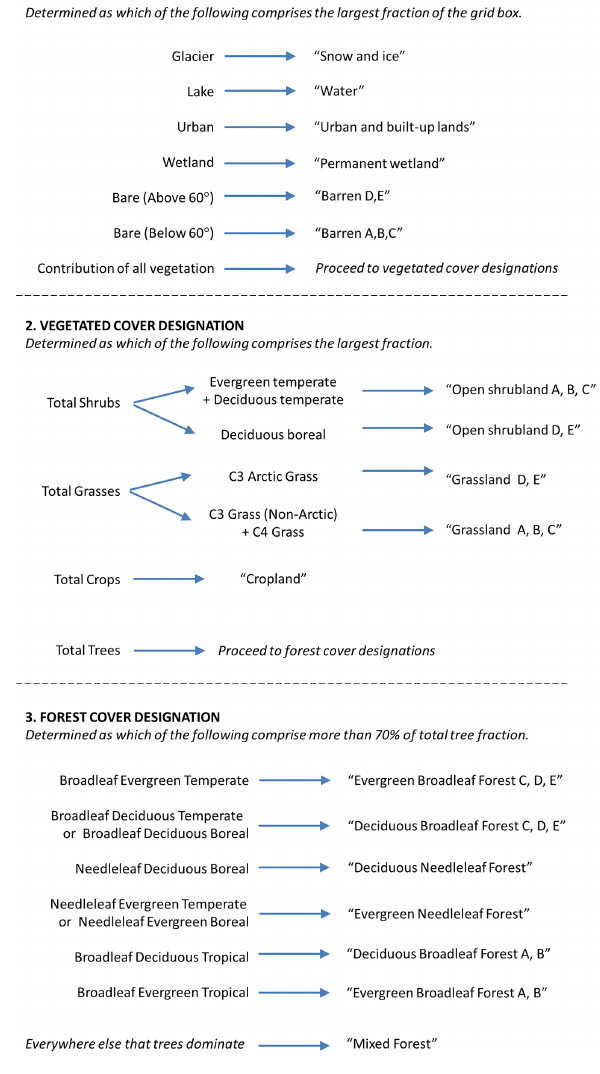
Figure A1. Mapping of native CLM land input classes to soil- NOx biomes (according to Steinkamp and Lawrence, 2011) for land cover harmonization in